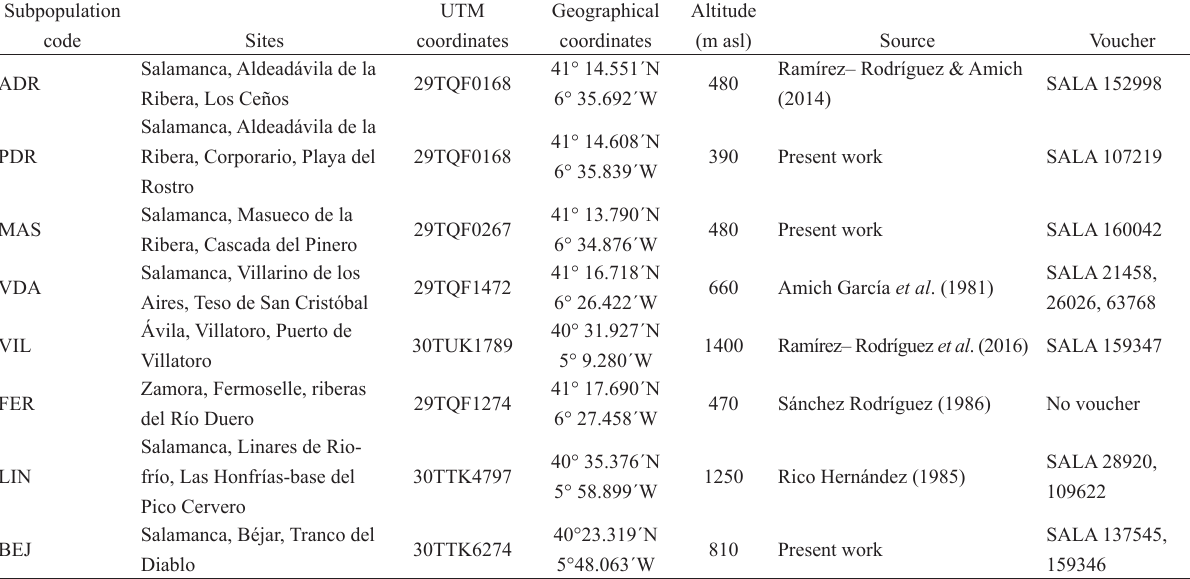
Table 1. List of Delphinium fissum subsp. sordidum sites located in Castile and Leon (Spain). Subpopulation